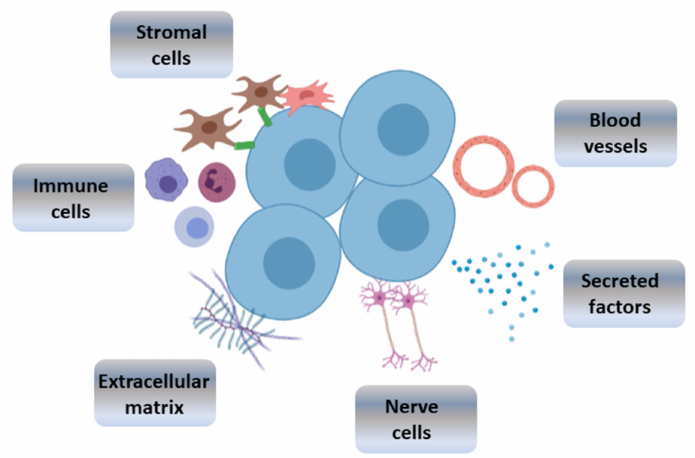
Figure 2. Schematic diagram of the stem cell niche showing the stem cells and the different com- ponents that interact with them: stromal cells, immune cells, extracellular matrix, nerve cells and signalling factors that are secreted by neighbouring cells or tissues. Blood vessels, which provide nutrients to the niche, are also depicted. The niche components are not drawn at scale. Adapted from Pennings et al. (2018)